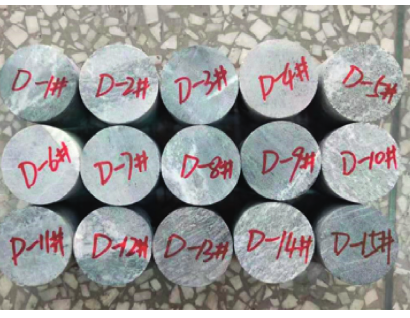
Figure 2: Dolomite marble.